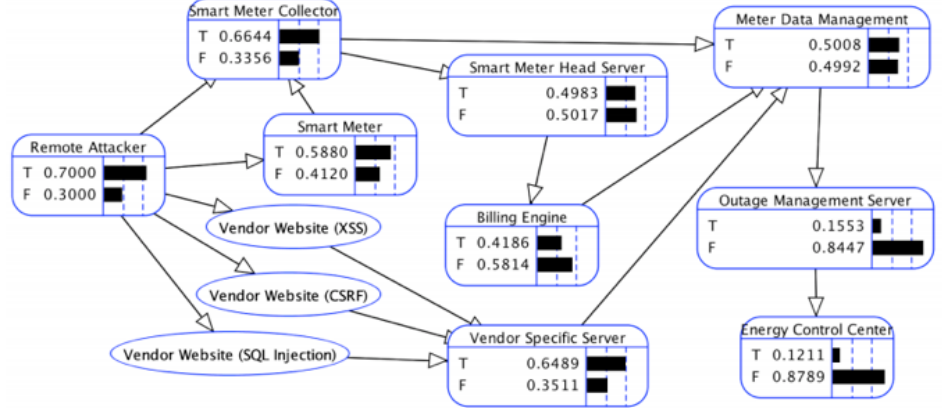
Figure 11. Unconditional probability distributions when the remote code execution vulnerability is discovered in the billing engine server. The effect of such a change is propagated to other components.